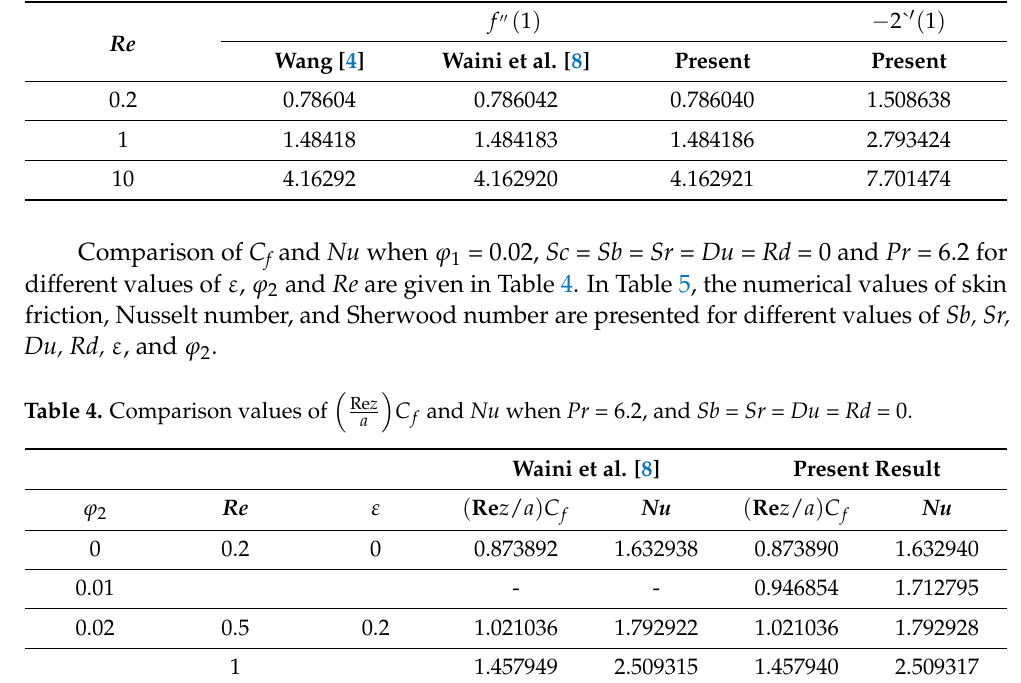
Table 3. Comparison of f (cid:48)(cid:48) ( 1 ) and − 2 θ (cid:48) ( 1 ) when Pr = 6.2, ε = 0, and Sb = Sr = Du = Rd = 0, ϕ 1 = ϕ 2 = 0.